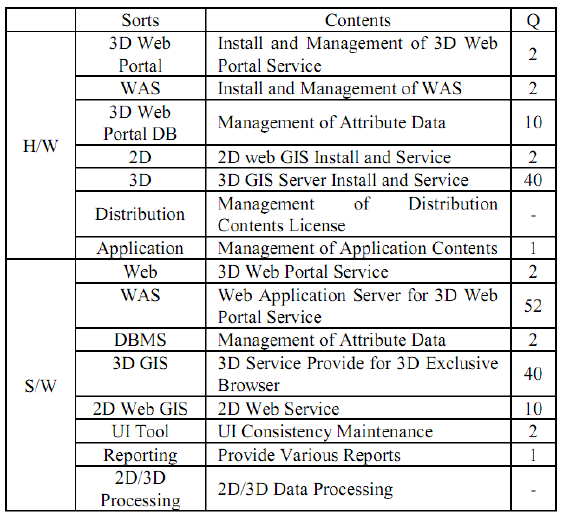
Table 2. Infrastructure of H/W and S/W